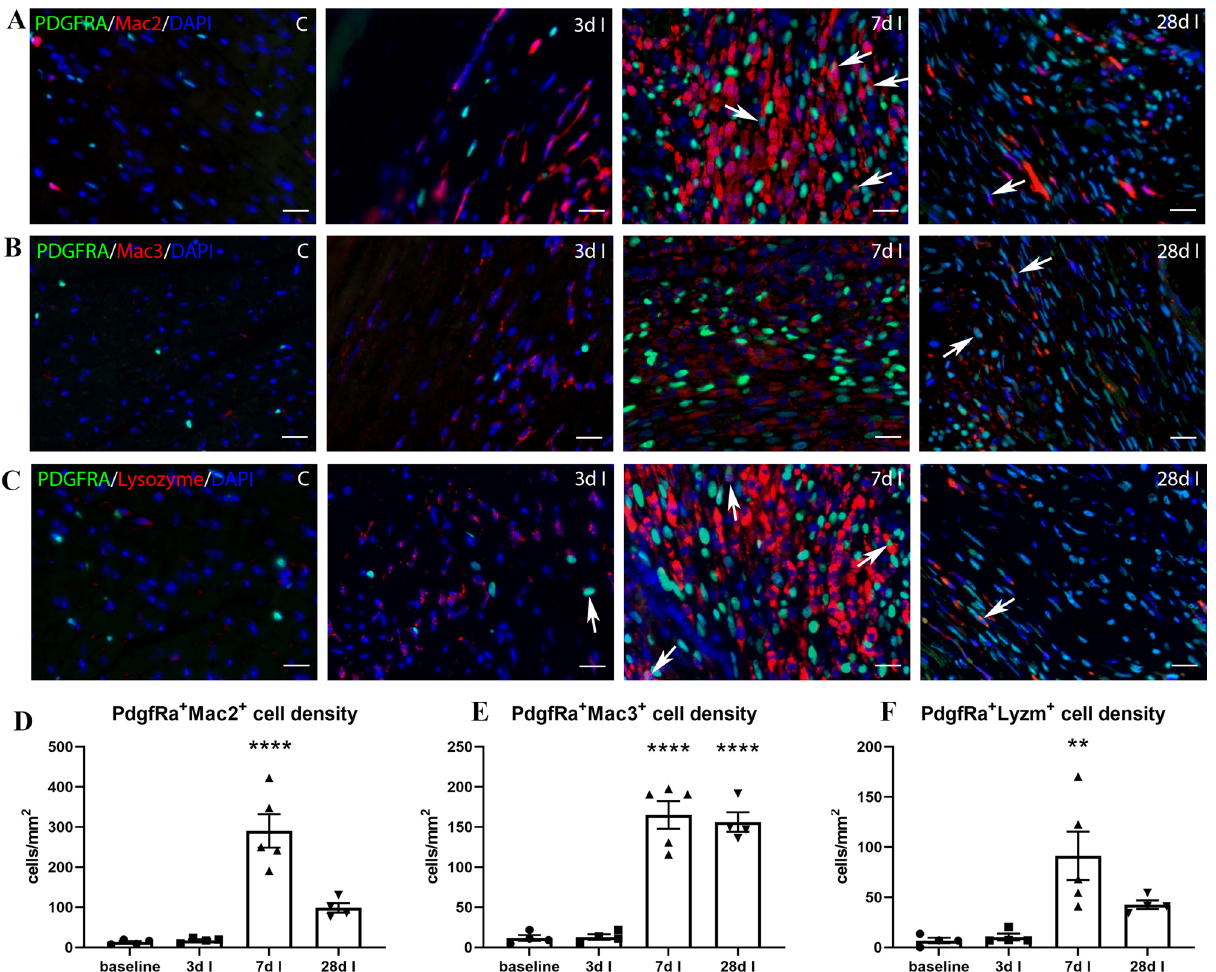
Figure 8. A population of PDGFRα+ fibroblasts, expressing the macrophage markers Mac2, Mac3, and Lysozyme-M emerges during the proliferative phase of infarct healing. PDGFRα-EGFP fibroblast reporter mice underwent non-reperfused myocardial infarction protocols. Dual immunofluorescence for GFP and macrophage antibodies (Mac2, Mac3, Lysozyme antibody clone EPR2994(2)) was performed in control hearts and in infarcted myocardial segments from mice undergoing 3-day, 7-day and 28-day coronary occlusion protocols. Control hearts and early infarcted hearts showed negligible numbers of PDGFRα+ fibroblast cells that express macrophage markers (arrows). At the peak of the proliferative phase (7d after coronary occlusion), a significant population of PDGFRα+ fibroblasts were Mac2 positive ( A , D ), Mac3 positive ( B , E ), or LyzM positive ( C , F ).In comparison to Mac2 and Mac3, LyzM labeled a lower number of PDGFR α + cells (**p < 0.01, ****p < 0.0001 vs. control, n = 4–5/group). Scale bar: 20